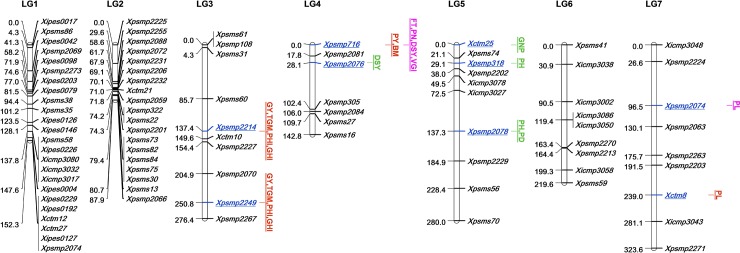
Linkage map of pearl millet showing significant GCA loci with LOD >5.0 and p<0.001.Significant GCA loci associated with traits in control (CN) (blue color), moisture stress (MS) (red color), CN+MS (pink color), CN+AMR (purple color), MS+AMR (green color) and CN+MS+AMR (maroon color) Note: FT-flowering time, PH- plant height, PL- Panicle length, PD- Panicle diameter, PN- Panicle number, PY- Panicle yield, GY- Grain yield, DSY- Dry stover yield, TGM- 1000-grain mass, GNP- grain number per panicle, BM- biomass yield, PHI- Panicle harvest index; GHI- grain harvest index, VGI-vegetative growth index.